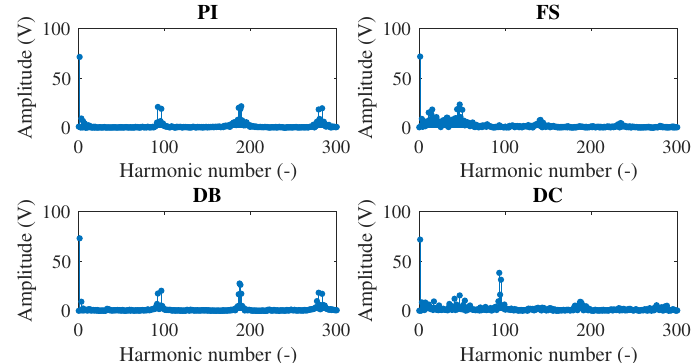
Figure 12. Voltage harmonics of phase a ( V dc = 200 V; N = 800 rpm; i ∗ q = 6